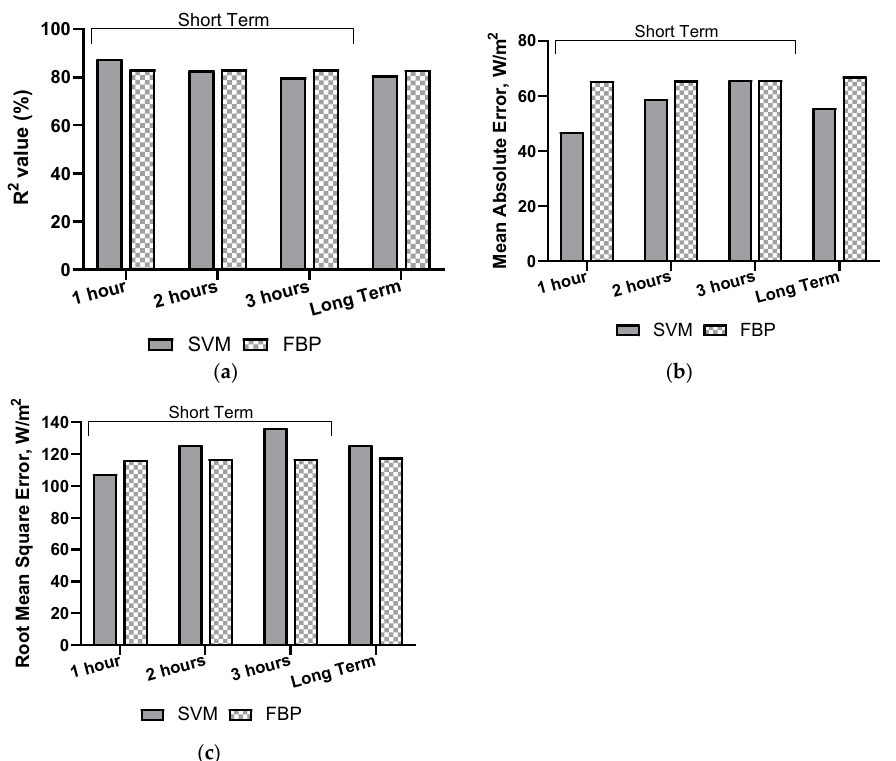
Figure 8. Error metrics comparing SVM and FBP for data-driven short- and long-term forecasts in Denver. ( a ) Coefficient of determination (R 2 ) ( b ) Mean absolute error ( c ) Root-mean-square error.